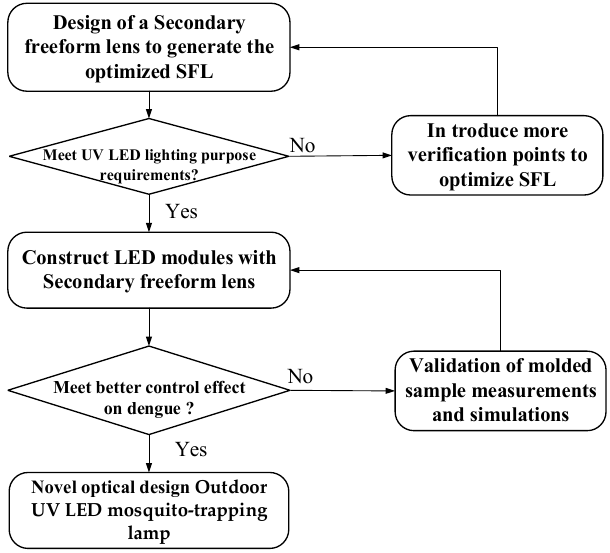
Figure 2. Design process of a secondary freeform lens (SFL).